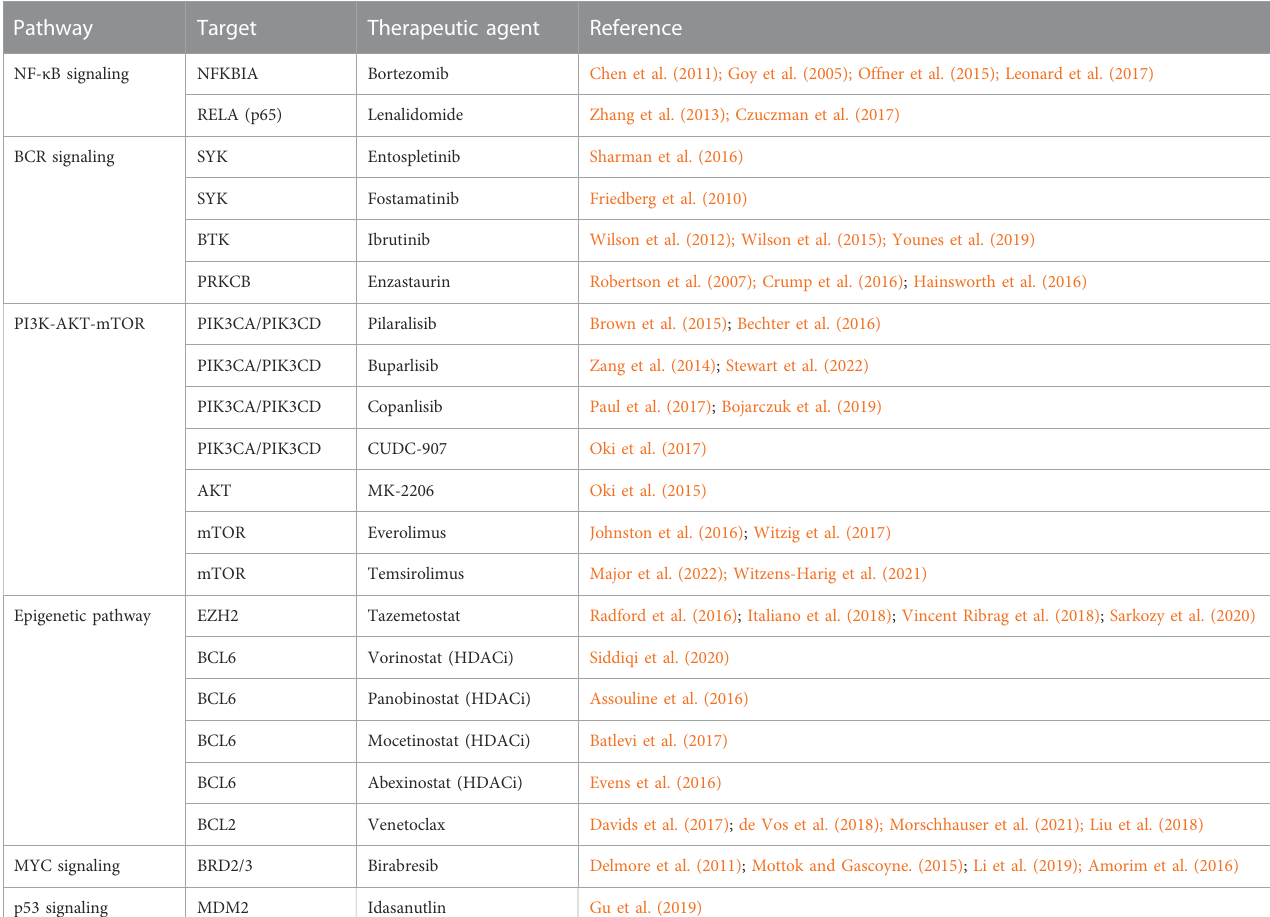
TABLE 2 Potential therapeutic agents in